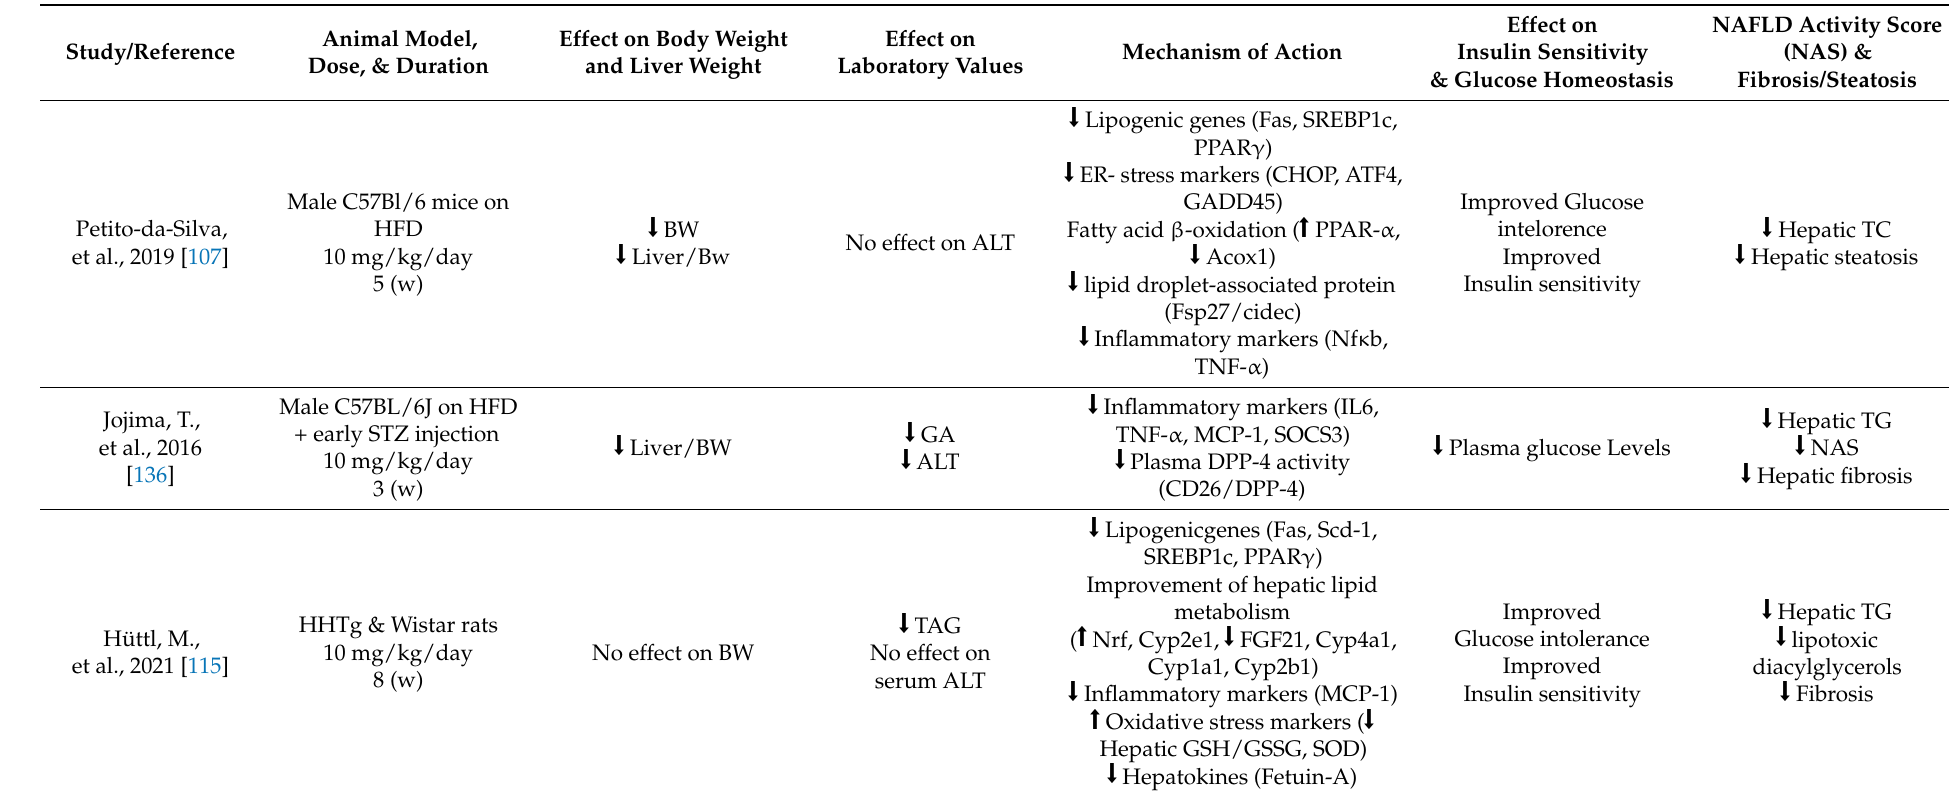
Table 1. Key animal studies regarding the impact of empagliflozin on NAFLD/NASH.